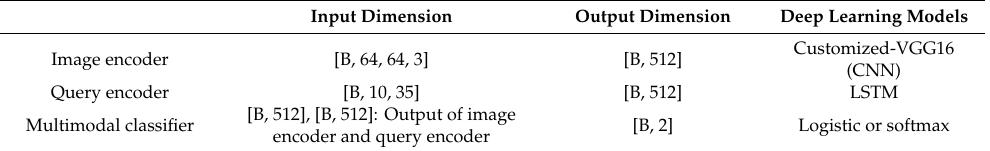
Table 1. Deep learning architecture of the proposed approach.